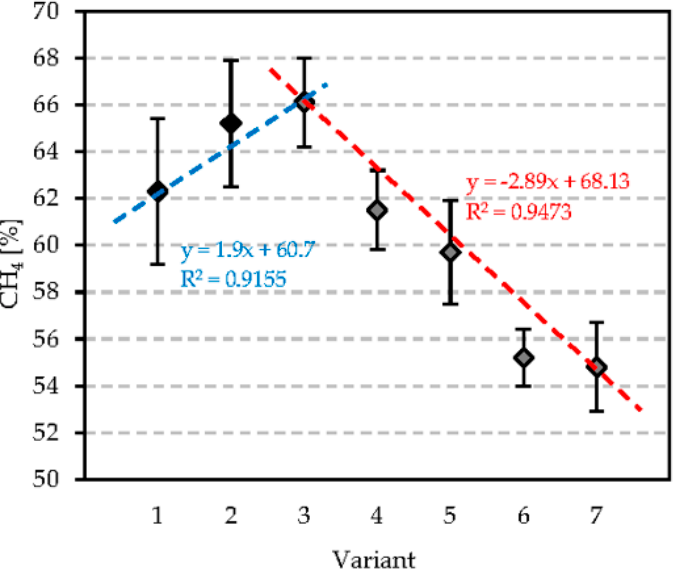
Figure 5. CH 4 in